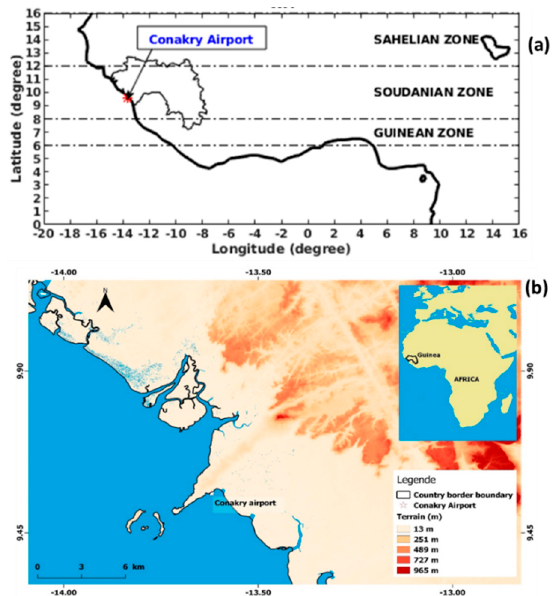
Figure 1. Geo-localisation of Conakry station in West Africa, map showing the three major west african climate zones ( a ), map showing Conakry Airport between Atlantic Ocean and Kakoulima Mountain range ( b ).